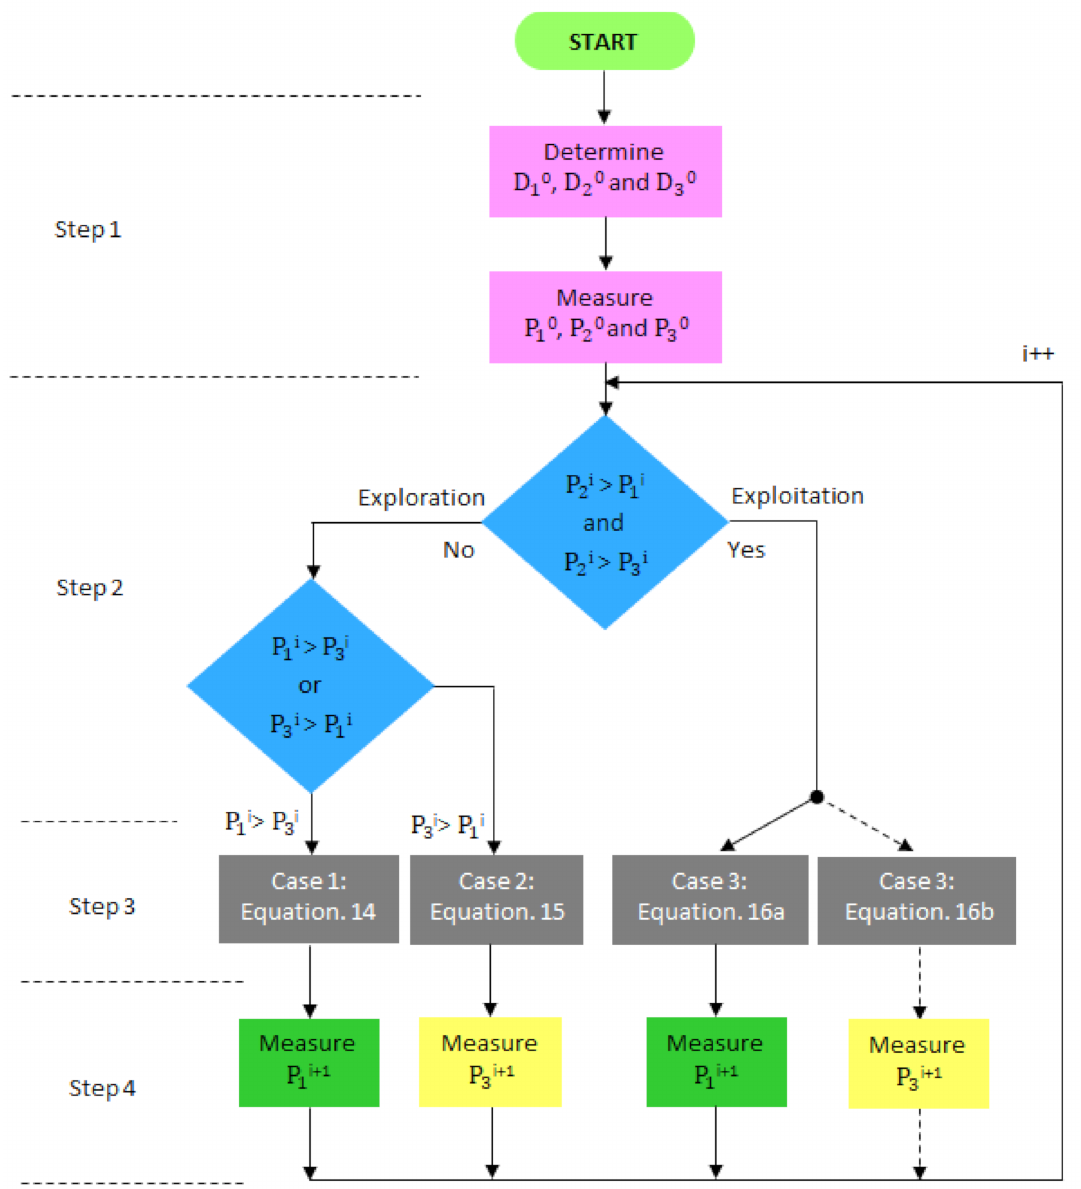
Figure 6. Flow chart of proposed